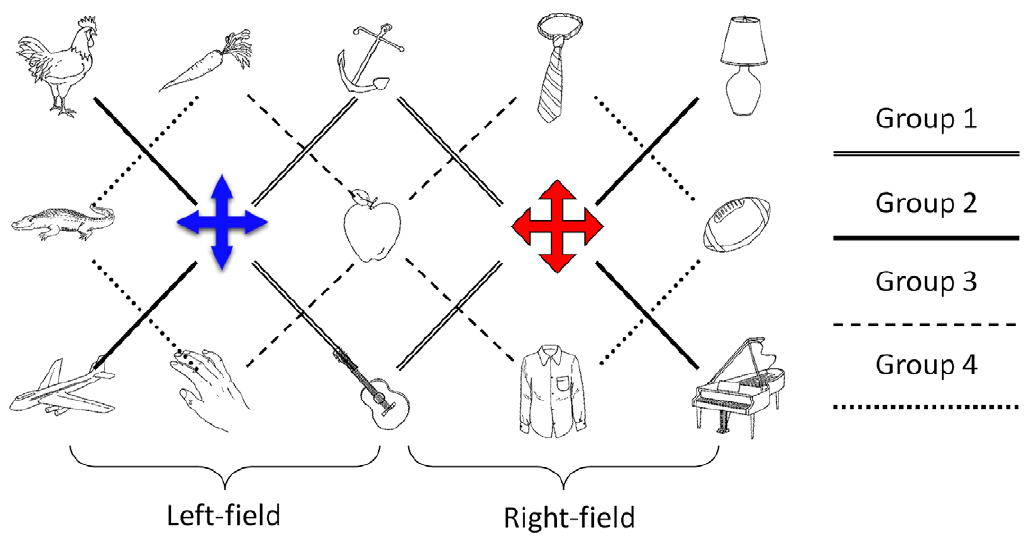
Figure 4. The object layout and the four focus groups in Experiment 2. The left cross is in blue and the right cross is in red. All other objects are in black-and-white.